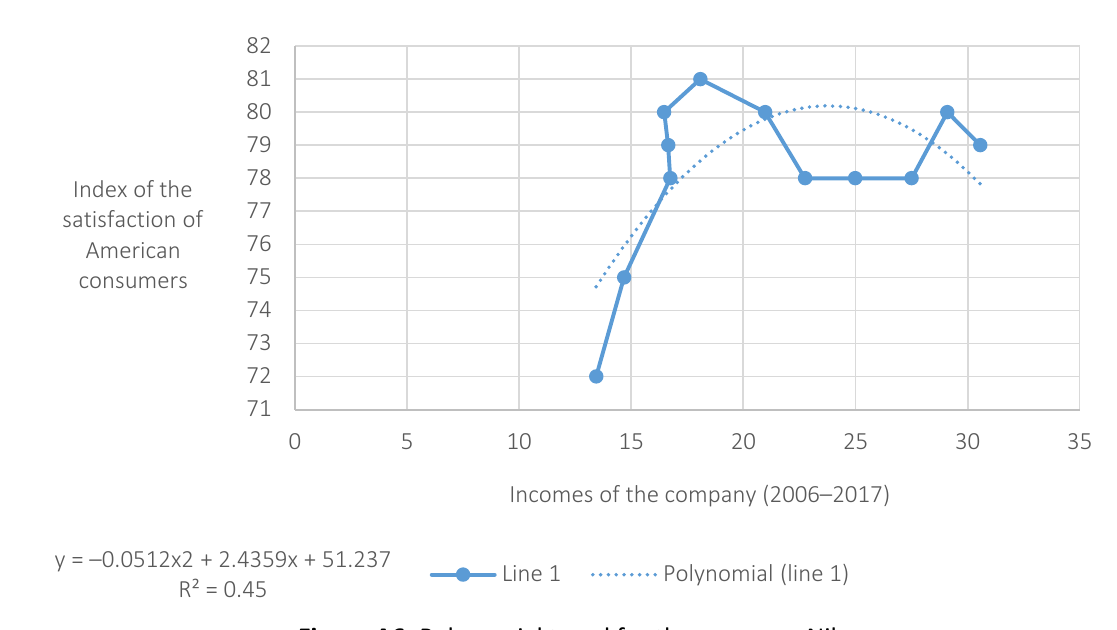
Figure A5. Linear trend for the company